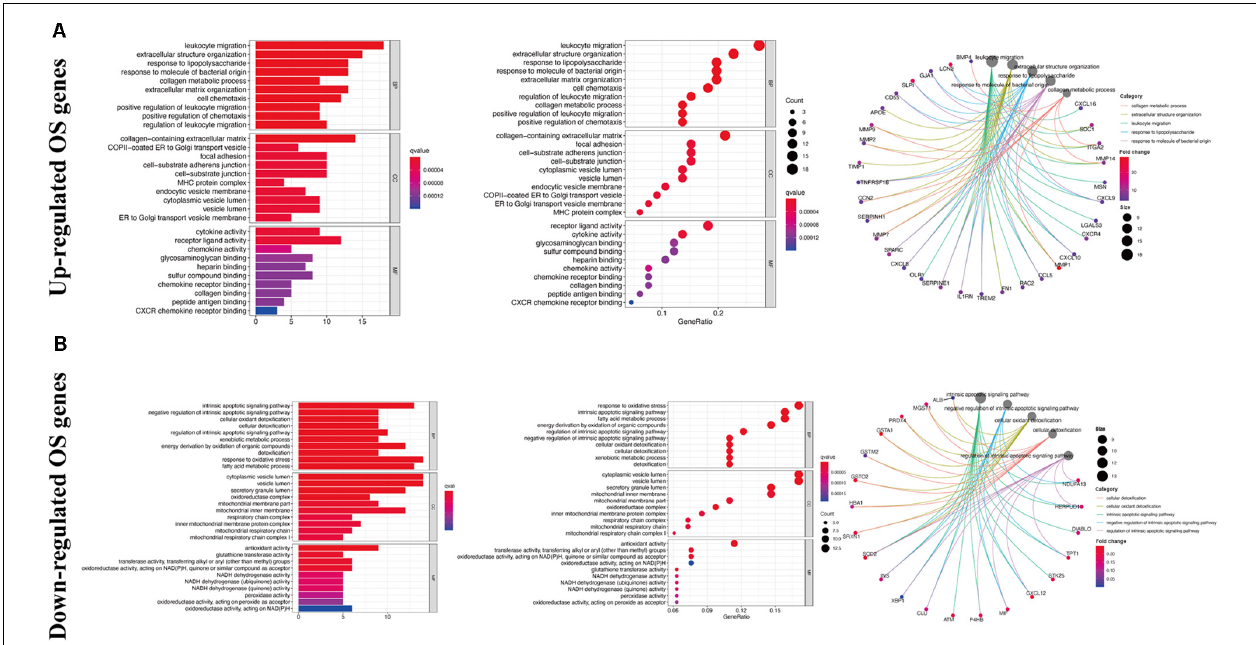
FIGURE 3 | Gene ontology enrichment analysis of DEOGs. (A) Top 10 classes of GO enrichment terms about up-regulated DEOGs in biological process (BP), cellular component (CC), and molecular function (MF). (B) Top 10 classes of GO enrichment terms about down-regulated DEOGs in BP, CC, and MF.